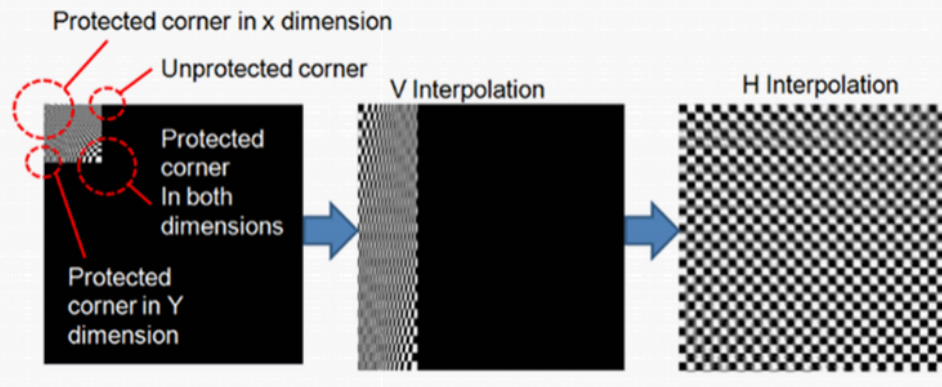
Figure 8. Separable interpolation